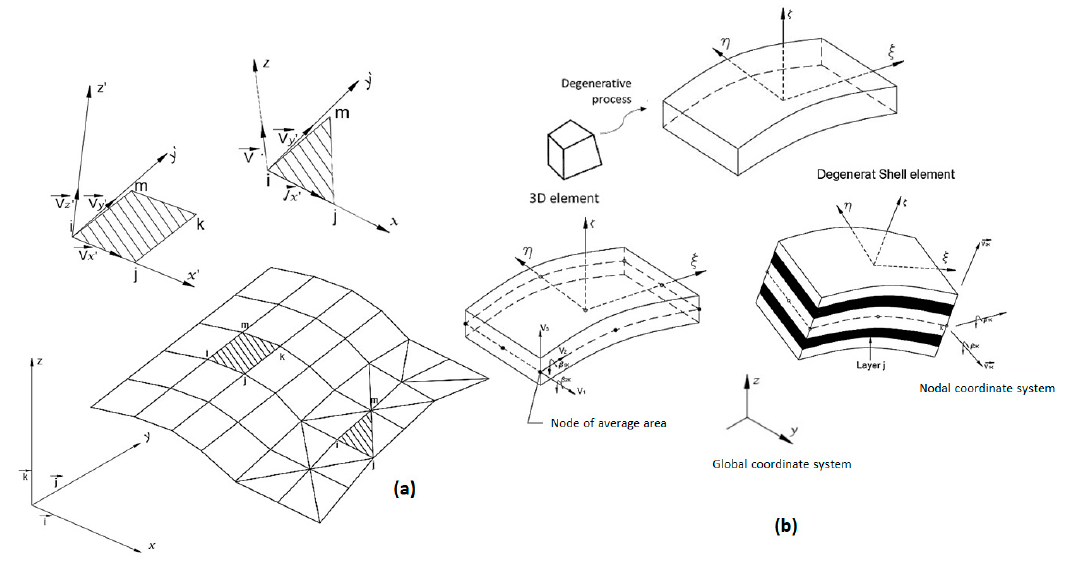
Figure 24. ( a ) Association of elements and ( b ) degenerate shell.